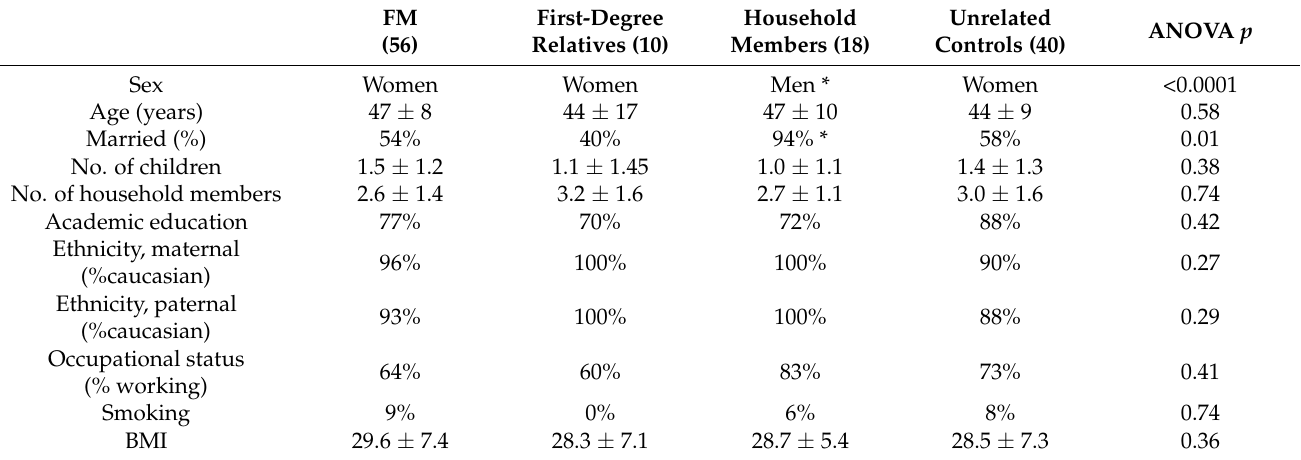
Table 1. Selected demographic and anthropometric characteristics of fibromyalgia patients and